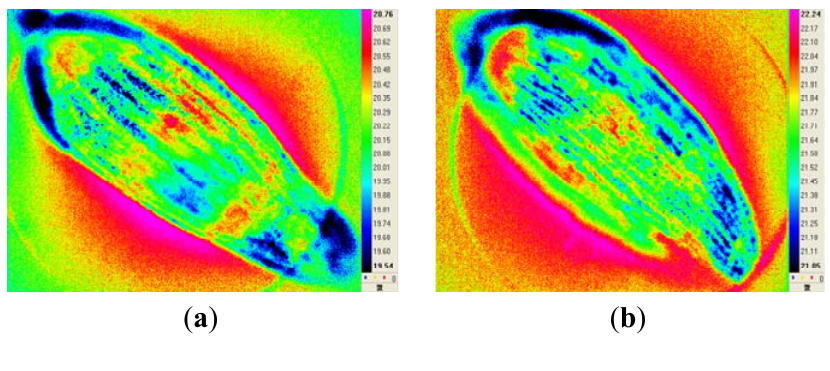
Figure 1. Infrared thermal images of a healthy seed ( a ), and seeds that were artificially aged for 24 h ( b ), 48 h ( c ), and 72 h ( d